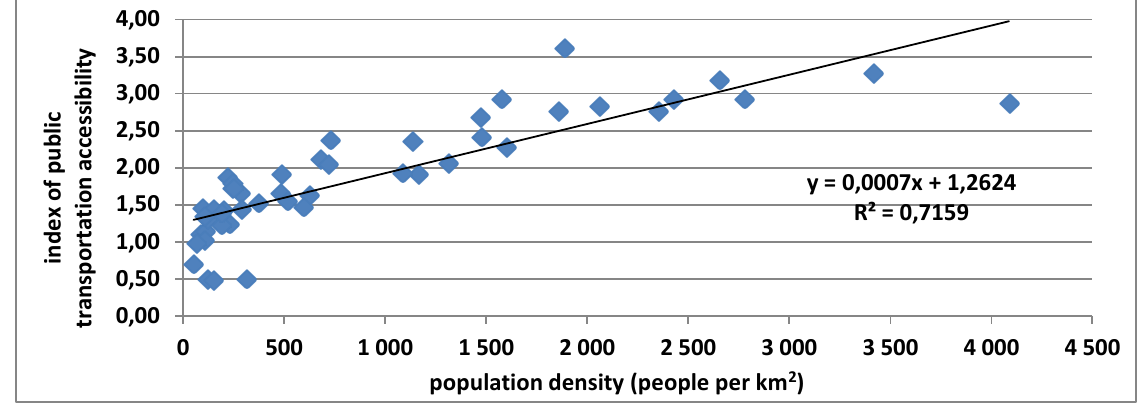
Fig. 6. Dependence between population density and public transportation accessibility in the communities of the Katowice conurbation (own